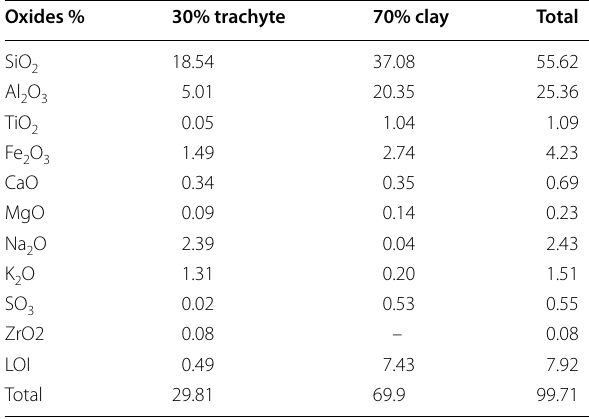
Table 4 Chemical composition of the design batch no. 3